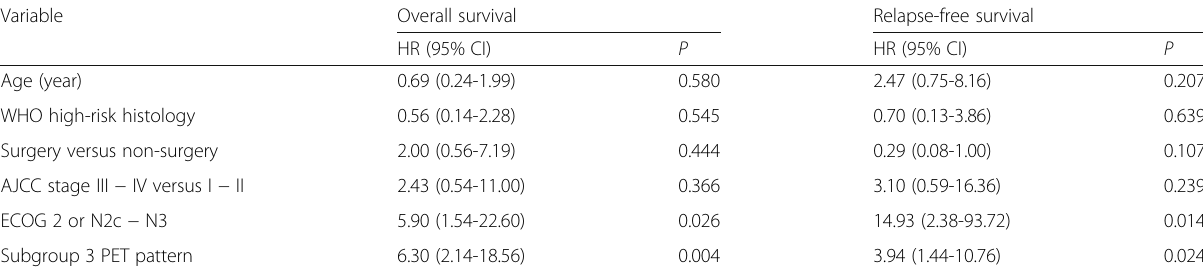
Table 2 Multivariable Cox proportional hazards regression analysis of overall and relapse-free survivals in the training group Variable